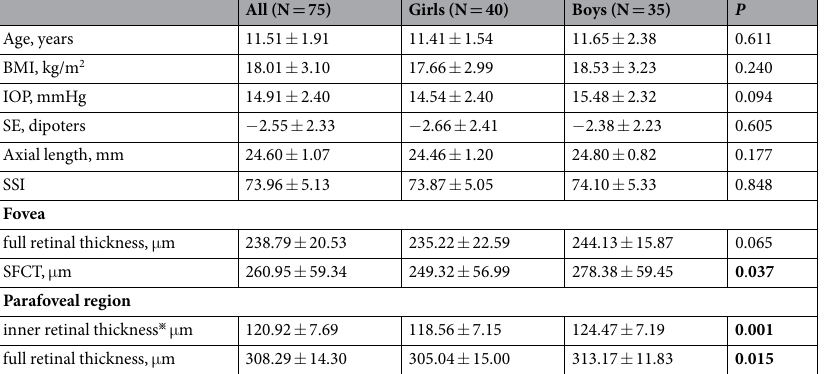
Table 1. Clinical characteristics of the study samples and optical coherence tomography measurements of retinal and subfoveal choroidal thickness according to sex. ※ OCT thickness from ILM to IPL; BMI, body mess indess; SE, spherical equivalent; SSI, signal strength index; SFCT, subfoveal choroidal thickness.